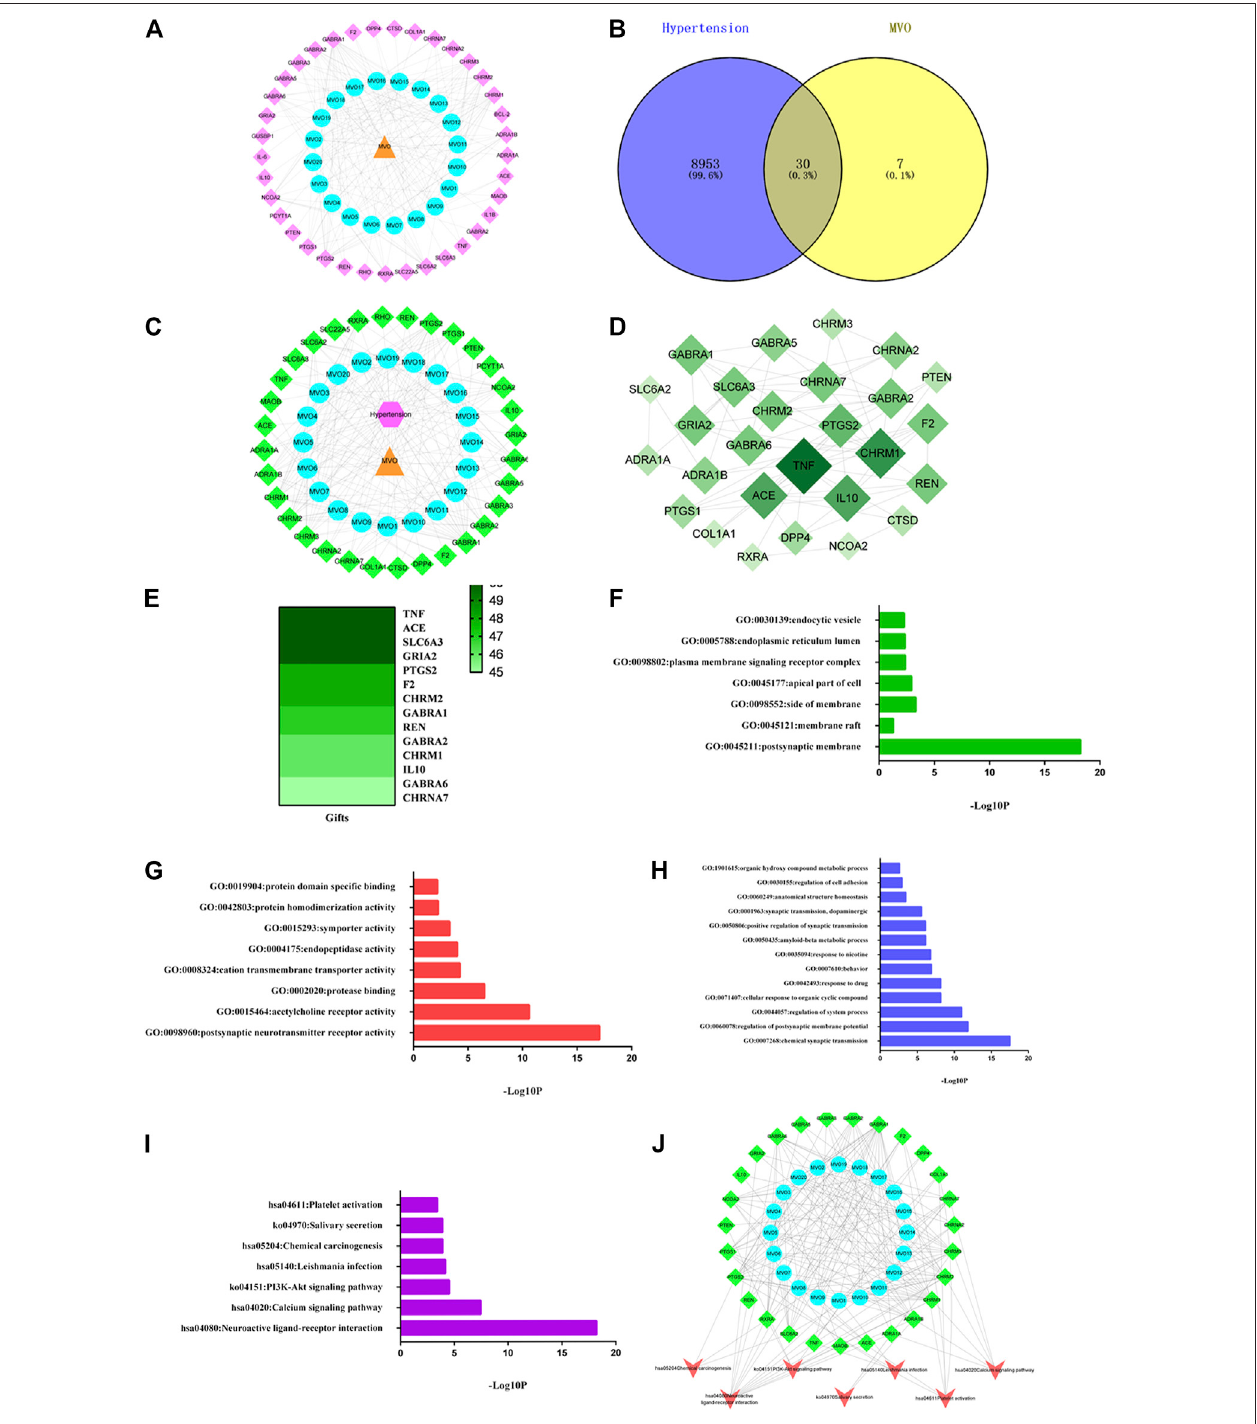
FIGURE 2 | MVO potentialtarget – hypertension target network and analysis. (A) The C-T network of MVO. (B) The Venn diagram. (C) The C-T-D network of MVO. (D) The PPI network of the 30 overlapping targets. (E) The heatmap of gifts between hypertension and hub target. (F) The GO-CC enrichment analysis. (G) The GO-MF enrichment analysis. (H) The GO-BP enrichment analysis. (I) The KEGG enrichment analysis. (J) The C-T-P network of MVO. The orange triangle node represented MVO,the bluecircle node representedeach compound ofMVO, thepink diamondnode represented thetargets ofMVO, thepink hexagonreferstohypertension, and the green diamond node represented the overlapping targets of MVO and hypertension; the red V was the symbol of pathways.